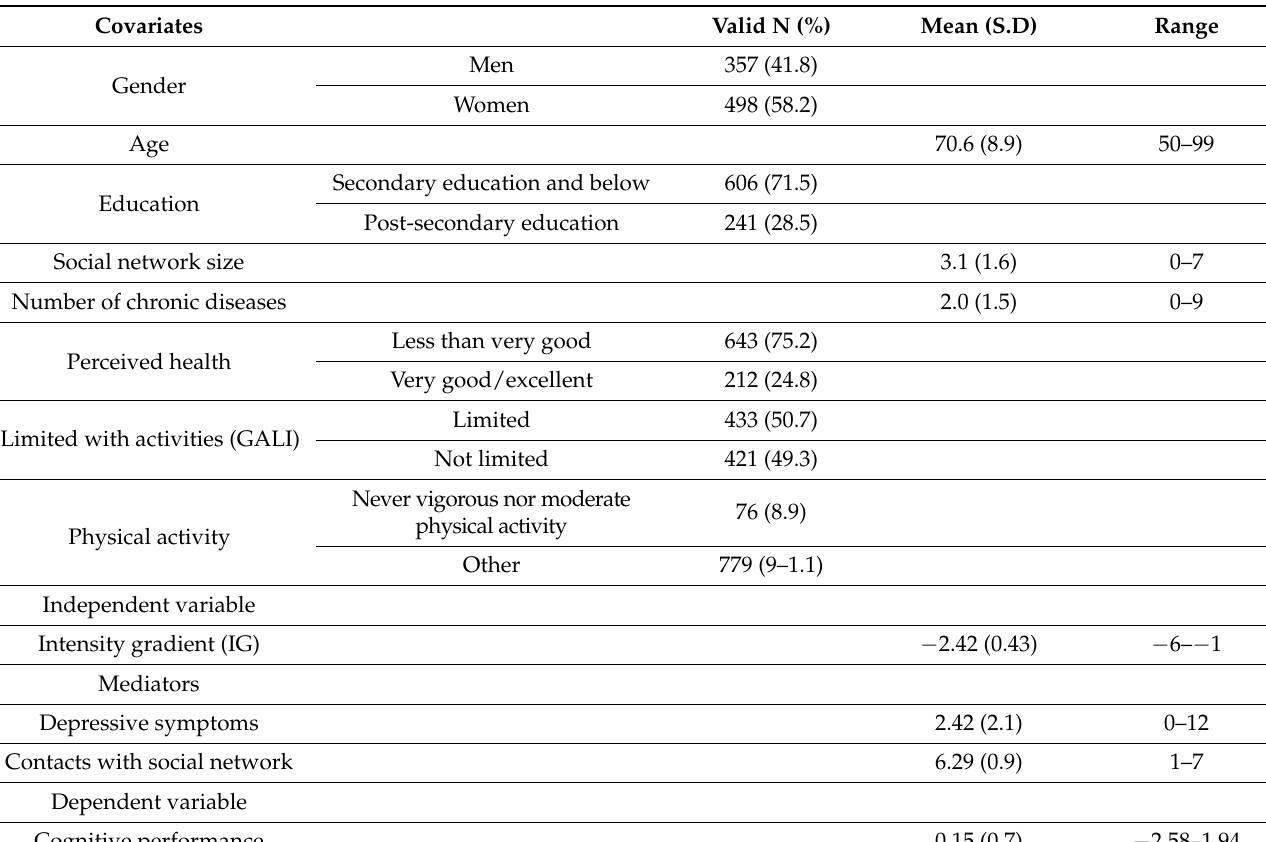
Table 1. Descriptive statistics of the study variables (N = 855).